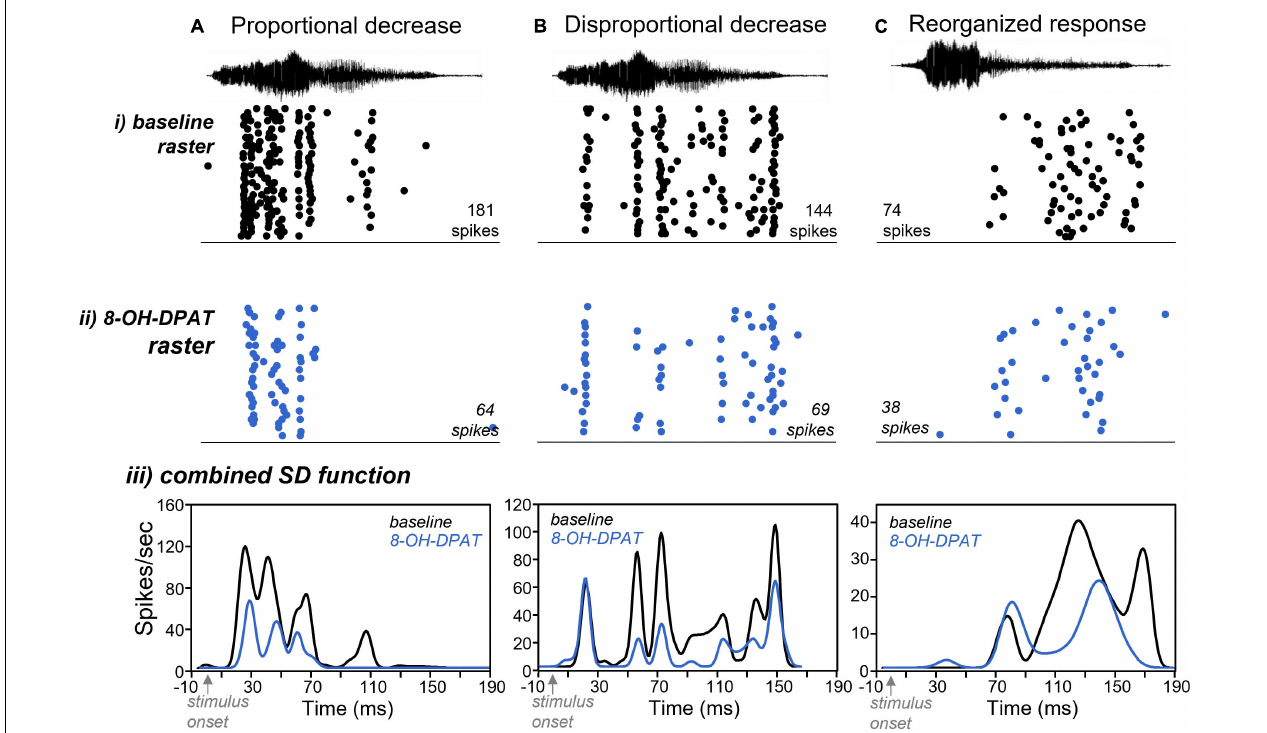
FIGURE 8 | Effects of 8-OH-DPAT on response features. (A) Raster plots of the responses of a neuron in (i) the baseline condition and (ii) during iontophoresis of 8-OH-DPAT. (iii) Spike density functions derived from the rater plots in (i) and (ii) . The neuron in (A) showed proportionally similar suppressions of all response features, with the loss of the smallest feature. Call 4 evoked this response. (B) Neuron showing selective decreases of response features in the middle of its spike train. Call 4 evoked this response. (C) Neuron showing a reorganization of its spike train in the presence of 8-OH-DPAT. Call 5 evoked this response. Time scale is the same for all